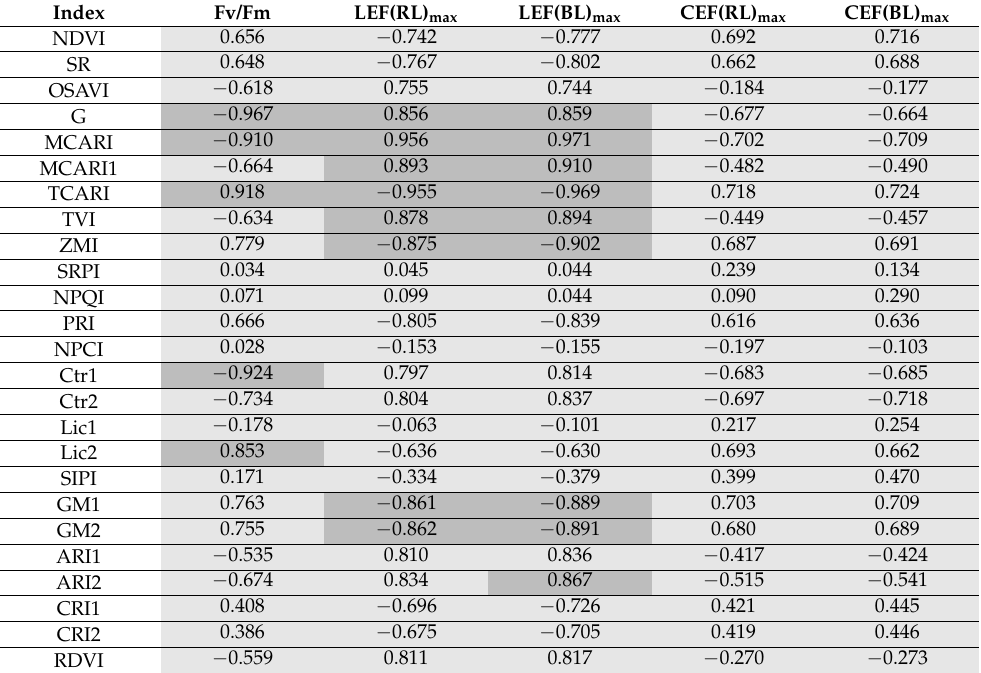
Table 2. Correlation coefficients between reflectance indices and parameters of photosynthetic light reactions including the maximal quantum yield of photosystem II (Fv/Fm), linear electron flows under the 978 µ mol m − 2 s − 1 RL intensity (LEF(RL) max ) and 758 µ mol m − 2 s − 1 BL intensity (LEF(BL) max ), and cyclic electron flows around photosystem I under the 978 µ mol m − 2 s − 1